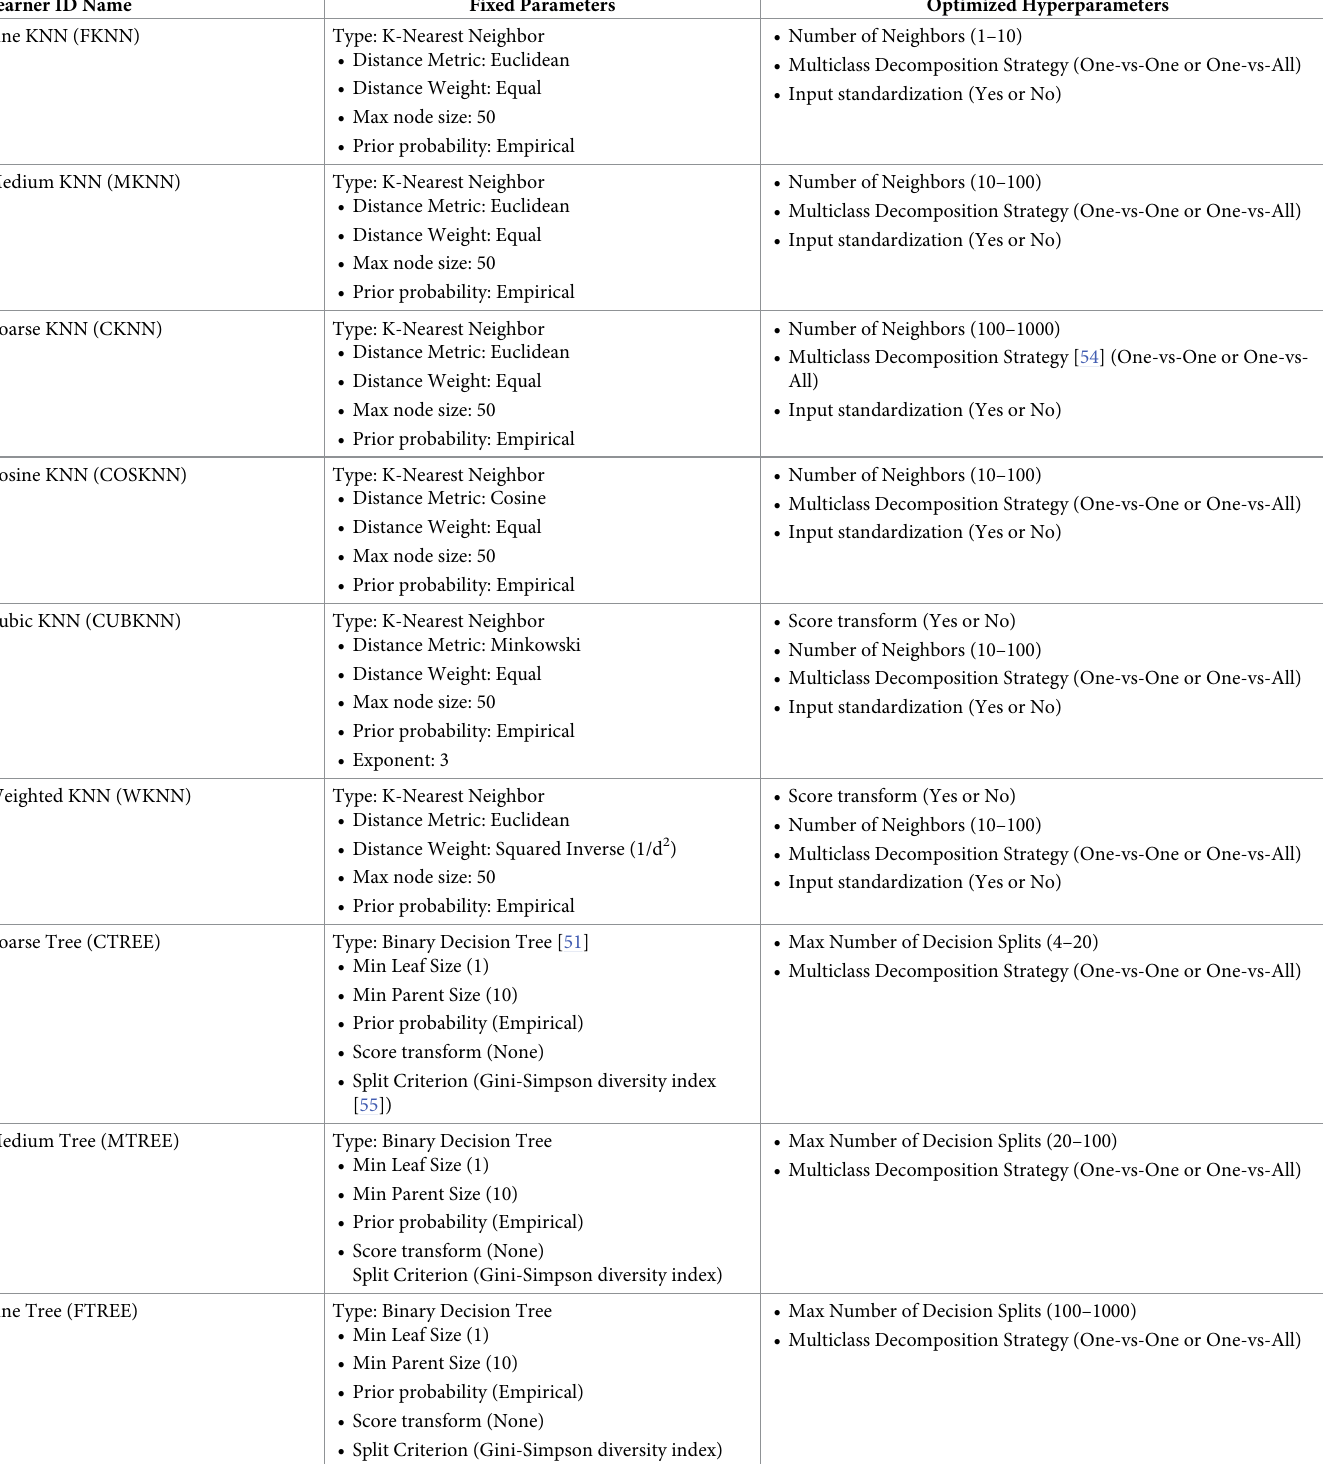
Table 4. The description of the hyperparameter optimization options and range of values for each ML